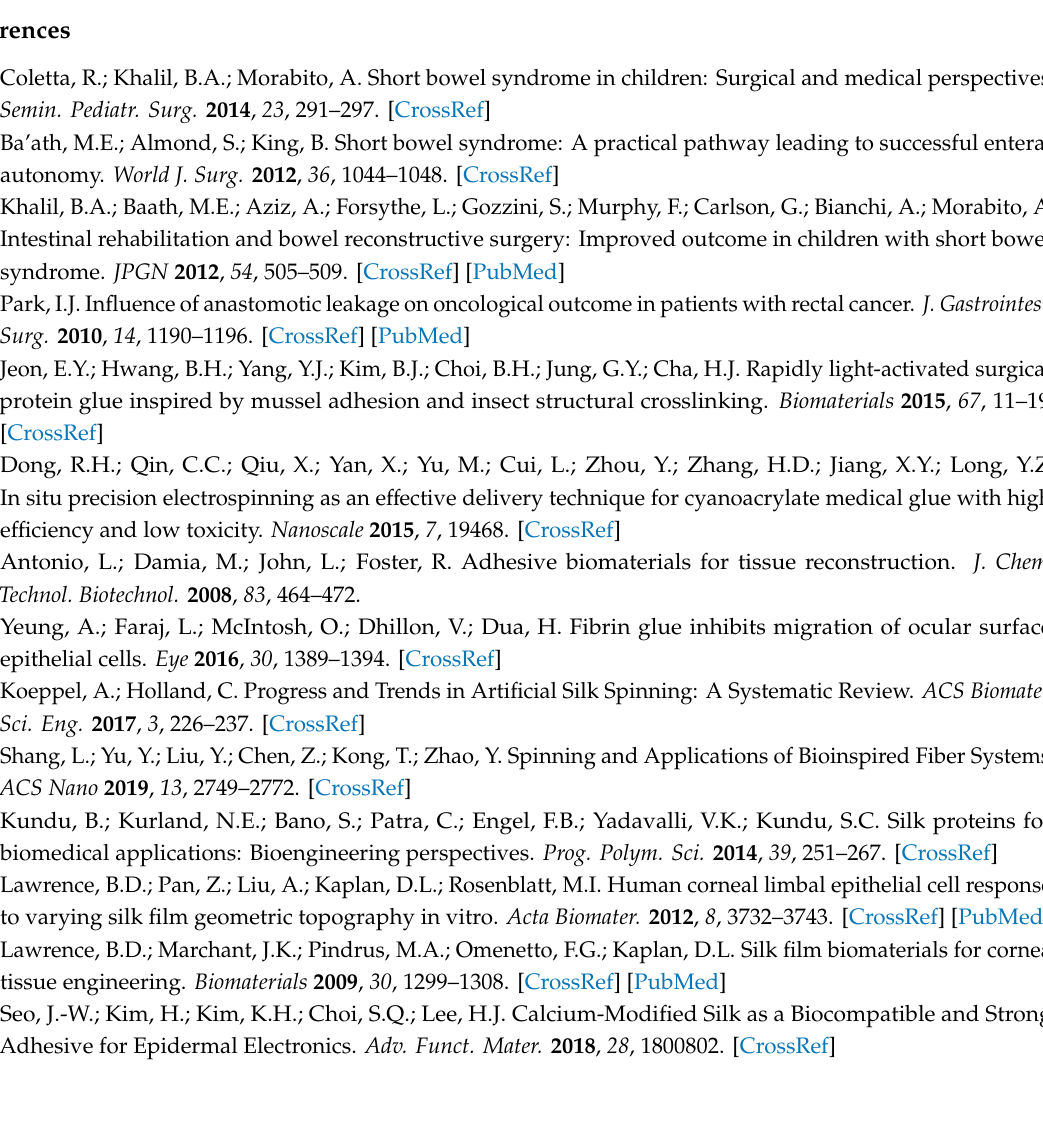
Figure S1: FESEM images of the prepared samples; Figure S2: FTIR spectra with fitting procedure; Figure S3: Stress-strain curves of the prepared samples; Figure S4: The generated output short circuit current of piezoelectric devices fabricated with di ff erent RS and RS-GNR films. Figure S5: Bursting machine designed for this work. Videos of the contact angle measurements. Video S1: Video of contact angle measurement on 70:30 RS film. Video S2: Video of contact angle measurement on 70:30 RS-GNR film. Video S3: Video of contact angle measurement on 80:20 RS